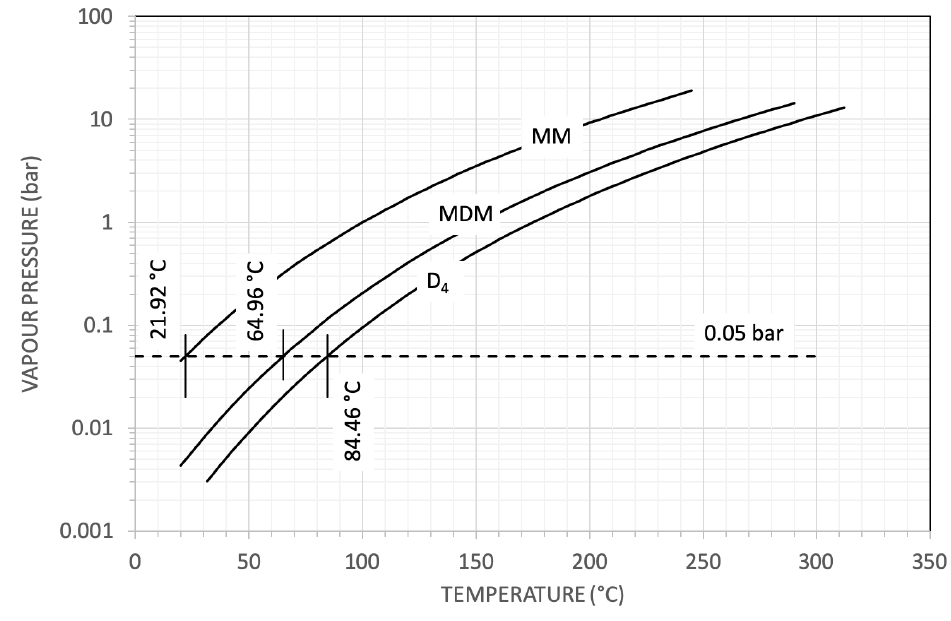
Figure 8. Vapour pressures curves for some siloxanes. From Aspen Plus ©